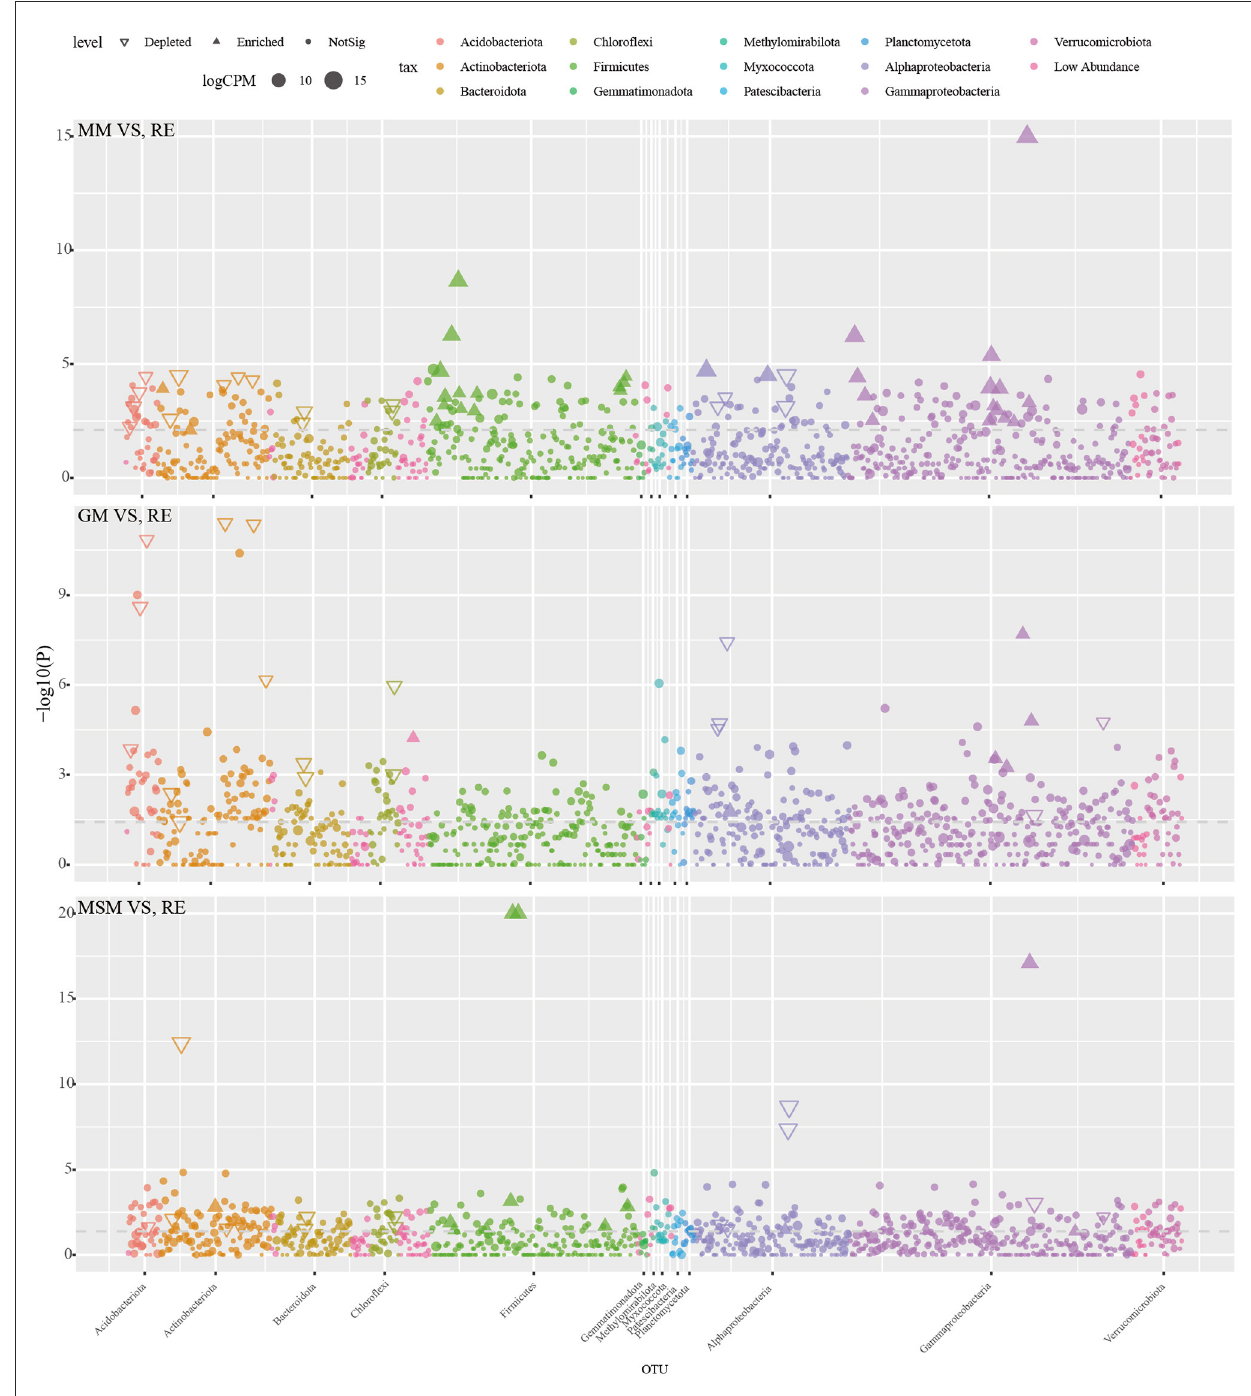
FIGURE4 The Manhattan plot illustrating the enrichment and depletion patterns of bacterial microbiota in the enrichment collections compared with the in situ root tissues. Table 1 presents a list of abbreviations of the groups used in the figure.